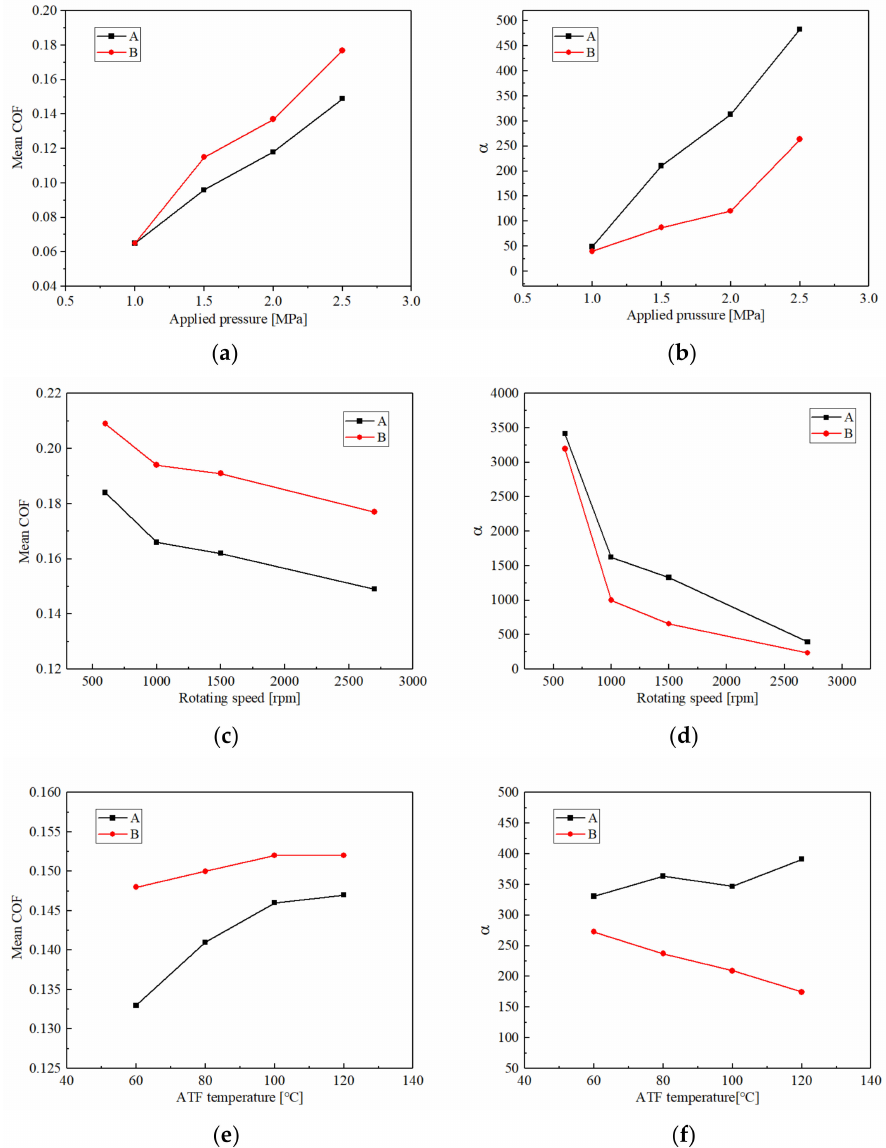
Figure 12. Mean COF and variable coefficient at different applied pressures ( a , b ), at different rotating speeds ( c , d ), and at different ATF temperatures ( e , f